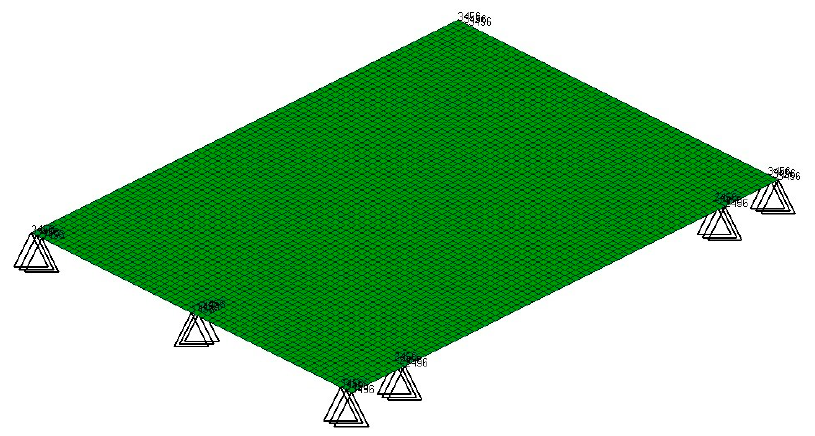
Figure 5. FEA model of flat plate.